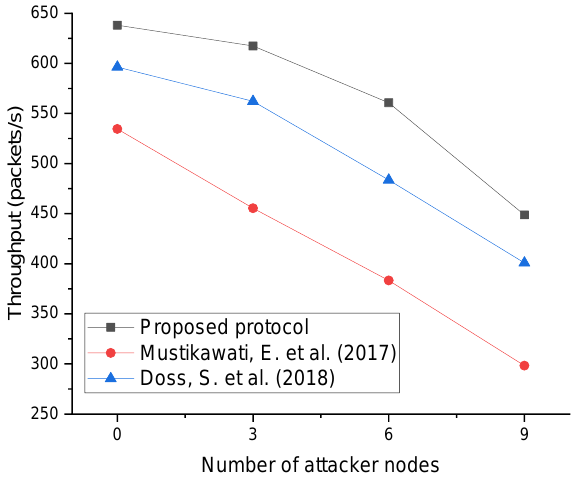
Figure 15. Nodes’ data throughput under Jellyfish delay variance attacks [20,37]. Figure 15. Node s’ data throughput under Jelly fish delay variance attacks [20,37].